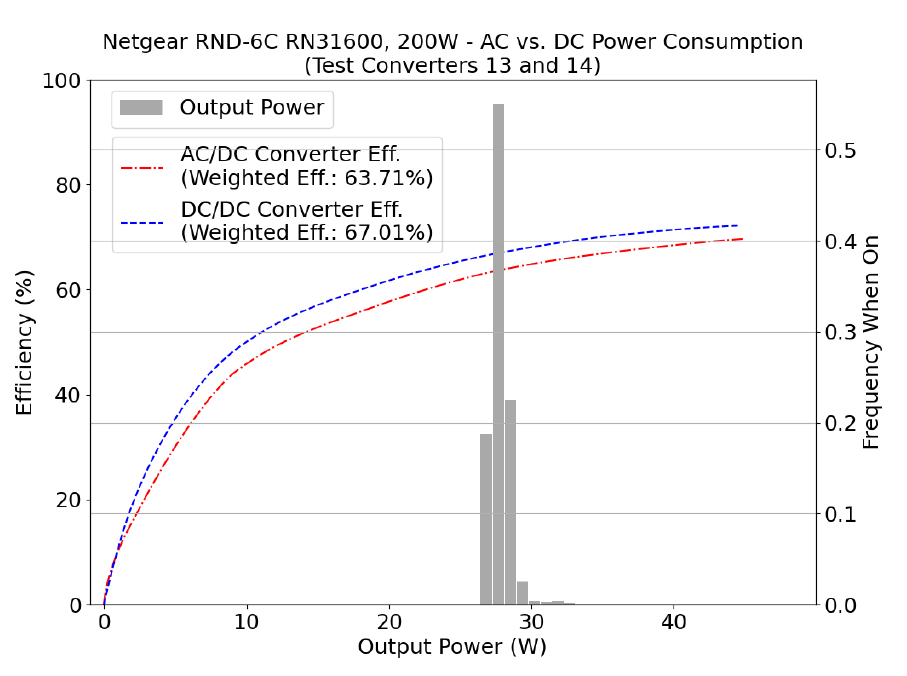
Figure 9. AC and DC weighted energy efficiencies for Netgear RND-6C RN31600 (200 W). Simulations were done with 185 W SIMO test converters. The figure shows a comparison with DC test converter rated at 24 V DC . Formatted as in Figure